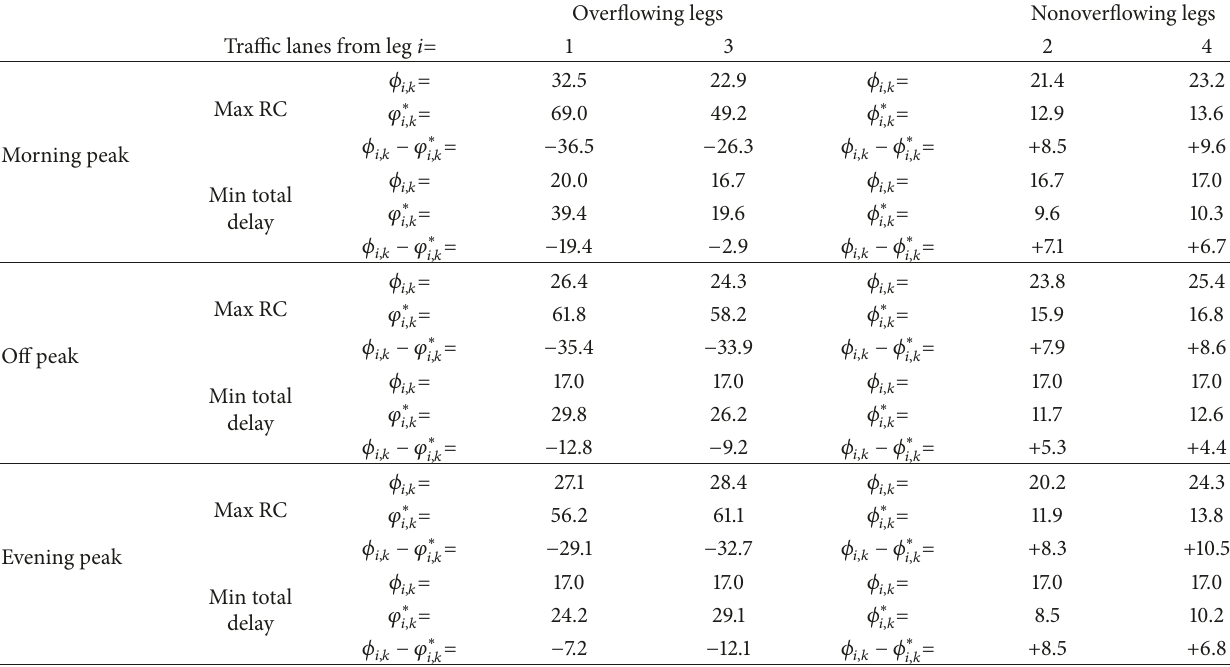
Table 2: Differences of green durations between traffic signal settings with spatial queue requirements and those without spatial queue